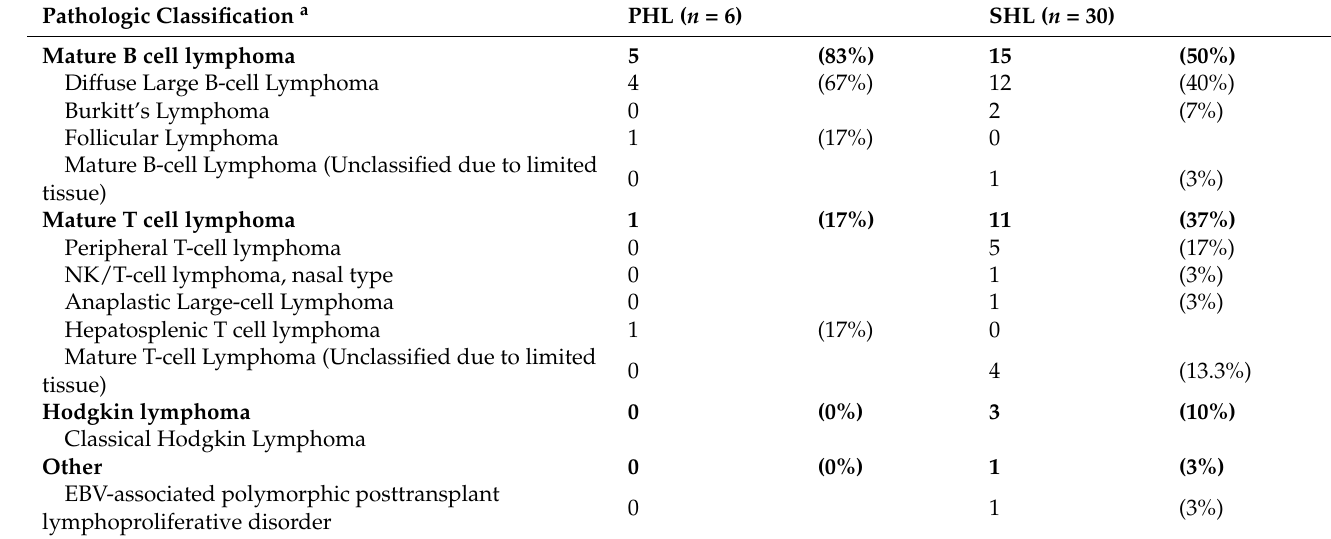
Table 1. Pathologic classification of hepatic